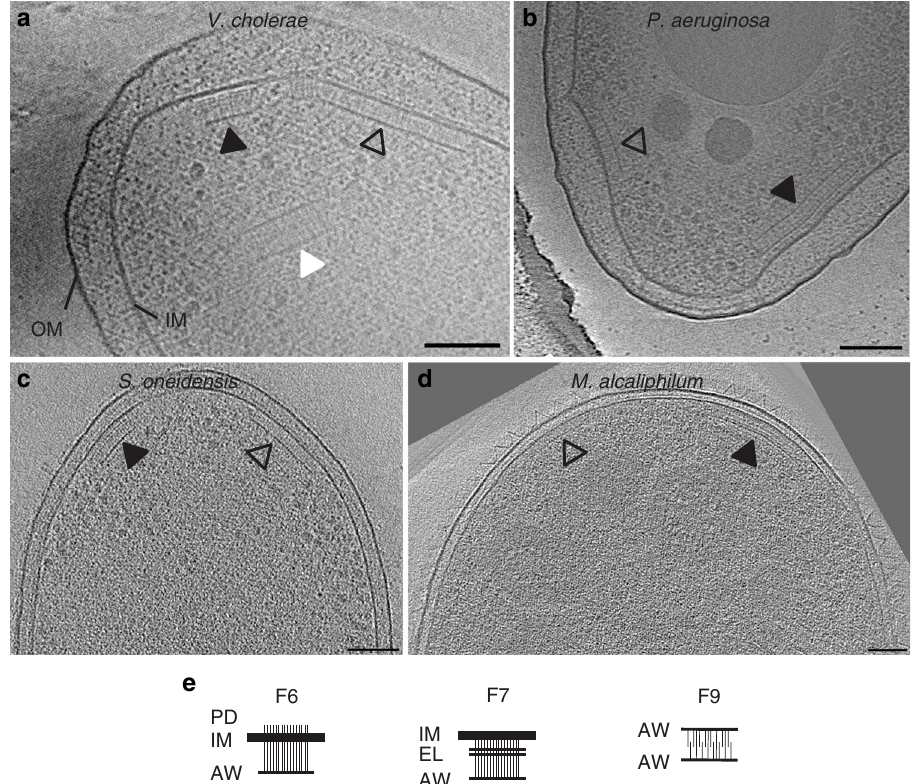
Fig. 1 Electron cryotomography of chemosensory arrays. Different putative chemosensory classes, F6 (empty arrows), F7 (black arrows), and F9 (white arrow), have different architectures when observed in side view in various γ -proteobacterial species: a V. cholerae , b P. aeruginosa , c S. oneidensis , and d M. alcaliphilum . Scale bars are 50 nm. e Diagrams of macromolecular features characteristic of the F6, F7, and F9 arrays. The F6 arrays span the inner membrane (IM) and have visible periplasmic domains (PD), and a CheA/CheW layer (AW). The F7 arrays are also membrane-bound but lack a PD. Instead, they have extra layers (EL) between the IM and the AW layer. The F9 cytoplasmic array is not bound to the membrane. Instead, the receptors are sandwiched between two AW